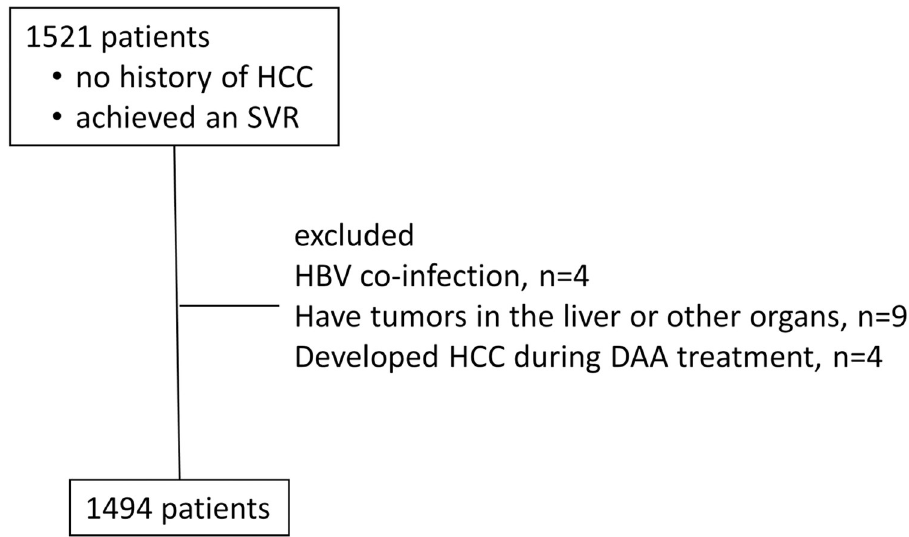
Fig 1. Flow chart of enrollment of the study population. HCC, hepatocellular carcinoma; DAA, direct acting